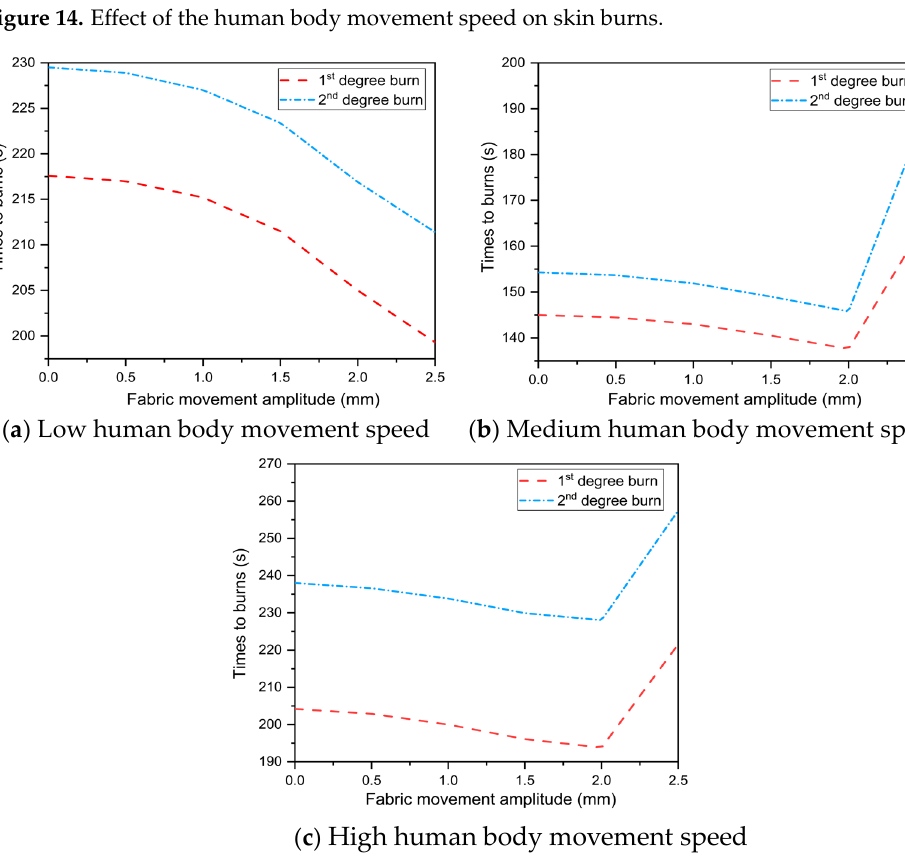
Figure 15. Effect of the fabric movement amplitude on skin burns at different levels of human body movement speed.